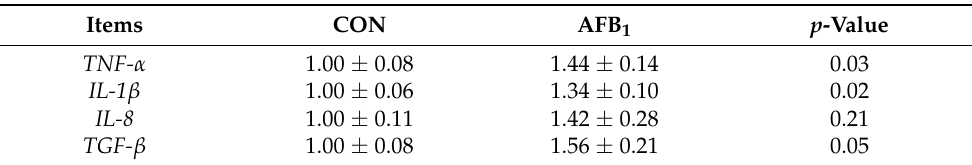
Table 10. Effects of AFB1 on the relative mRNA expressions of inflammatory related genes in jejunal mucosa of pigs.